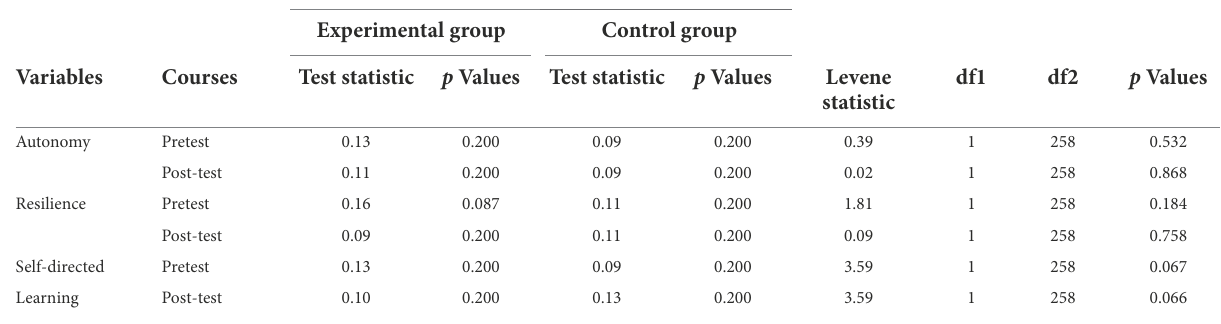
TABLE 2 Data normality test and variance